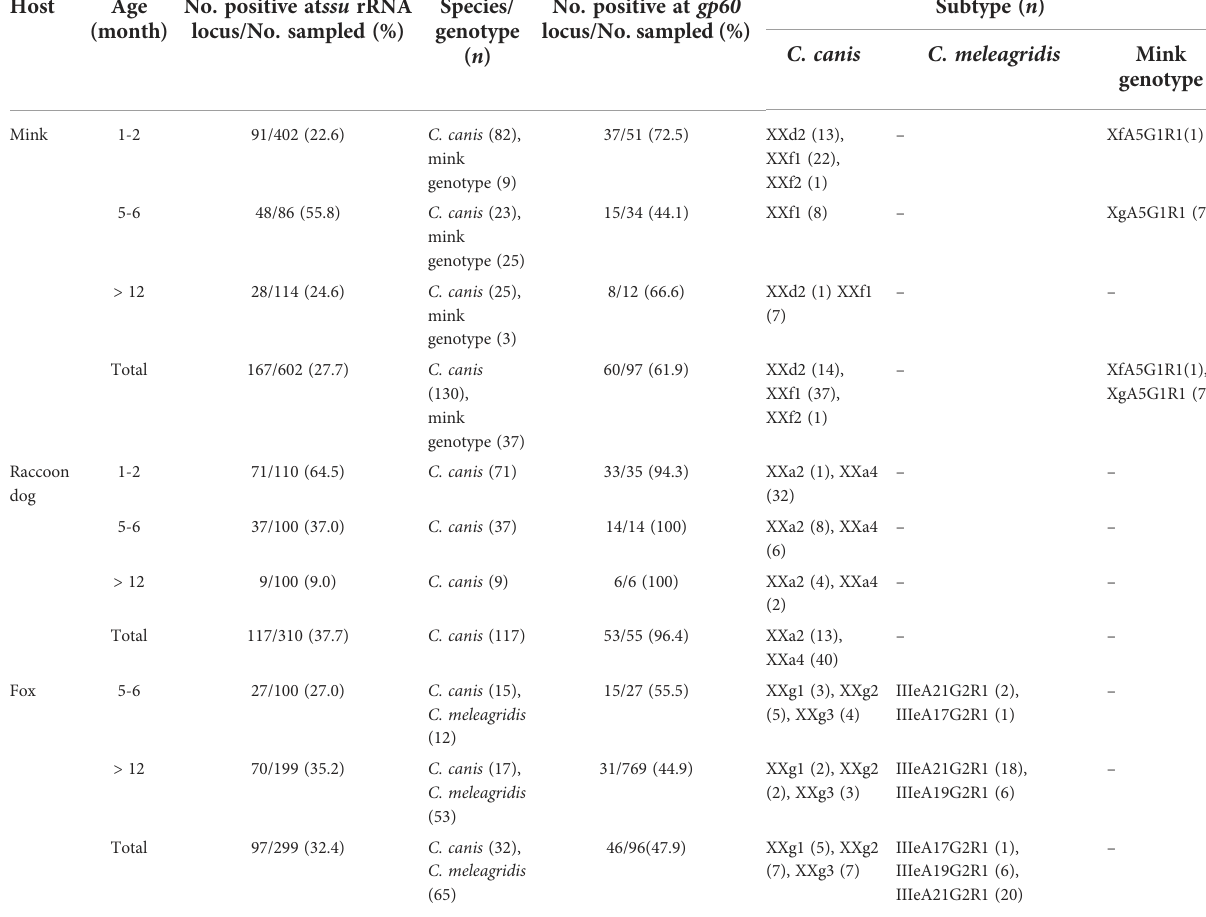
TABLE 1 Occurrence of Cryptosporidium species/genotypes and subtypes in minks, raccoon dogs and foxes on two farms in Shandong, China.